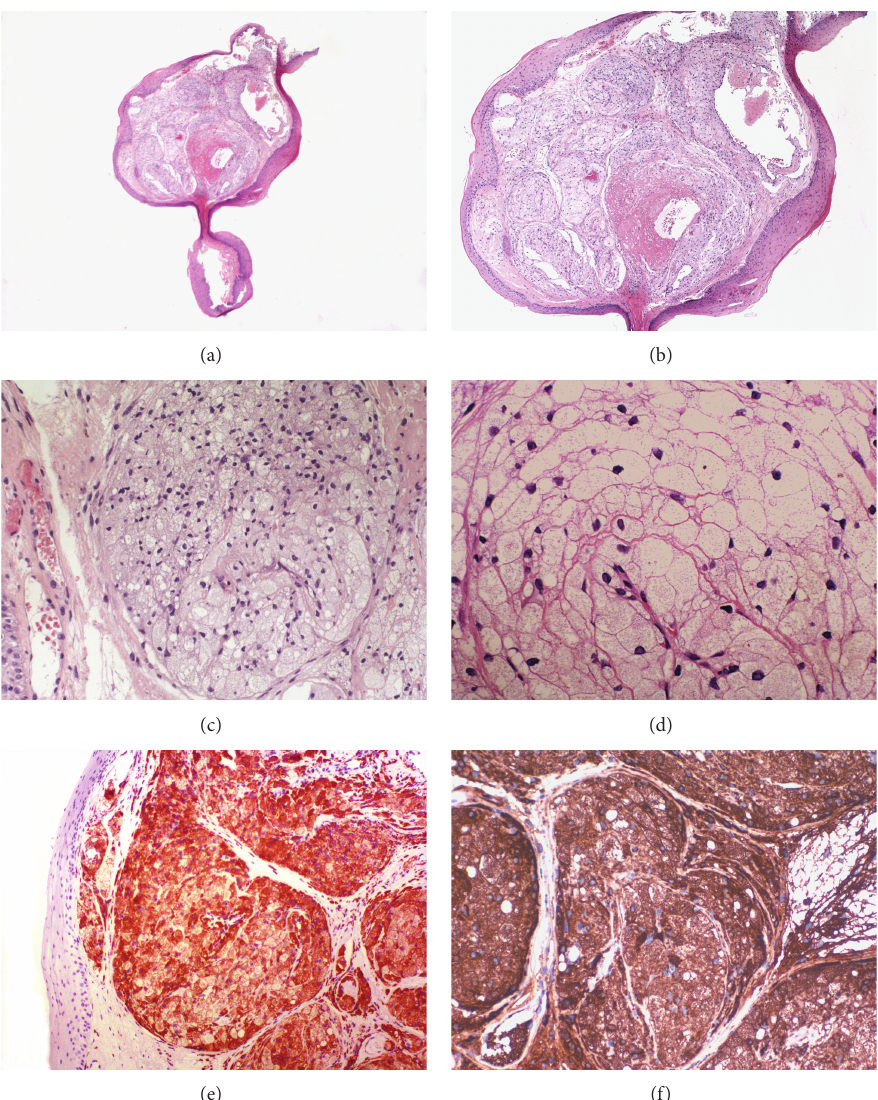
Figure1:Panoramichistologicalviewofthelaryngealpolypoidlesion(1a)(H-E,15x).Frequentisletsofclearfoamcellswithcongestivevessels areseenbelowalaryngealsquamousepitheliumwithoutatypia(1b)(H-E,100x). Athighermagnifications, thefoamcellshaveaxanthomatous appearance (1c) (H-E, 250x) and are negative for PAS (1d) (PAS, 400x). Immunohistochemical staining shows intense cytoplasmic reactivity in the foam cells against CD68 (ie) (CD68, 250x) and adipophilin (1f) (adipophilin,